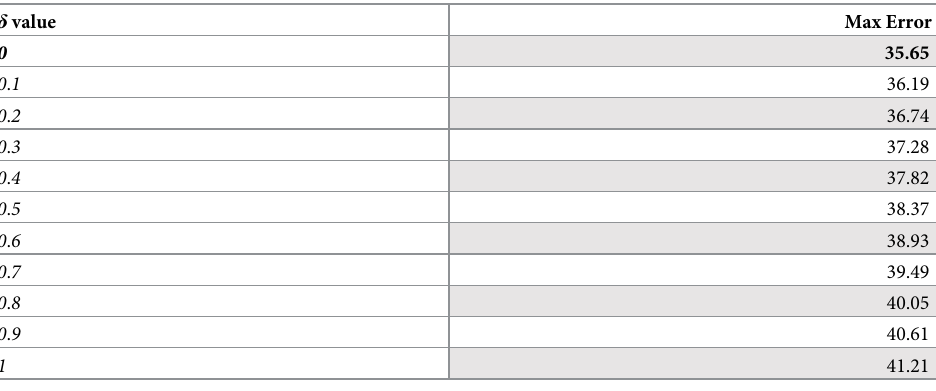
Table 4. Results of the preliminary experiment for δ parameter.